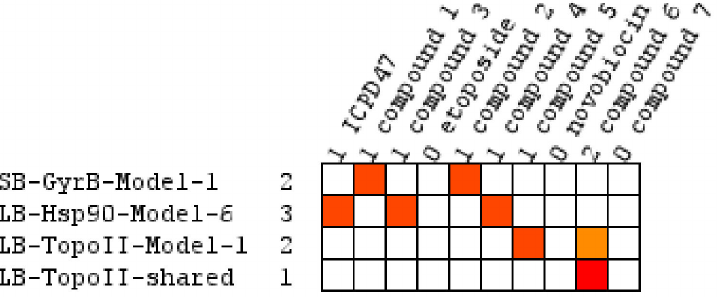
Figure 15. Virtual screening hits in the activity profiling of compounds 1 – 7 and positive controls ICDP47B, novobiocin, and etoposide using GyrB, Hsp90, and TopoII pharmacophore